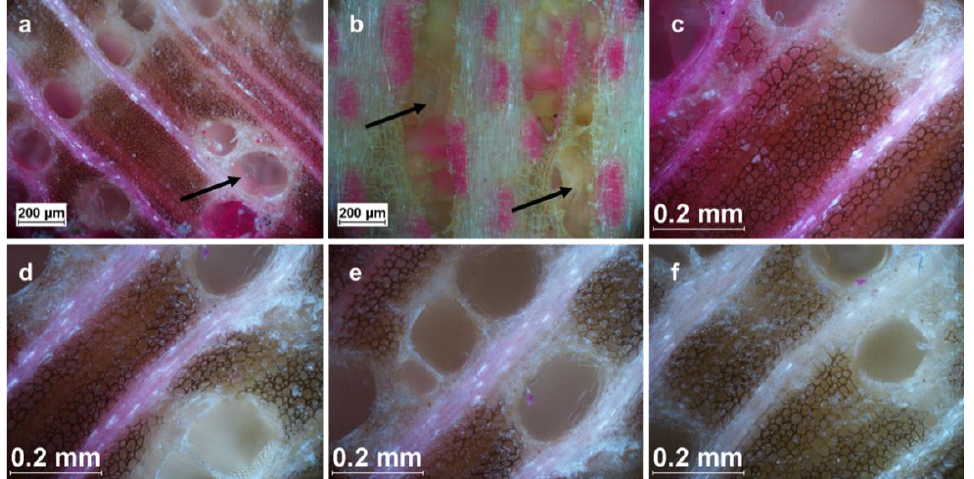
Figure 3. ( a , b ) Presence and abundance of tyloses (black arrows) in vessels revealed in cross-section and radial direction. Movement of colored liquid within a few micrometers from the edge of the sample and a discontinued penetration especially along the rays ( c – f ). Crystal-like substances are abundant in the rays, and movement of colored solution in the rays appeared to be discontinued due to crystal-like structure. Images in c to f were taken in sequence from the edge of the impreg- nated